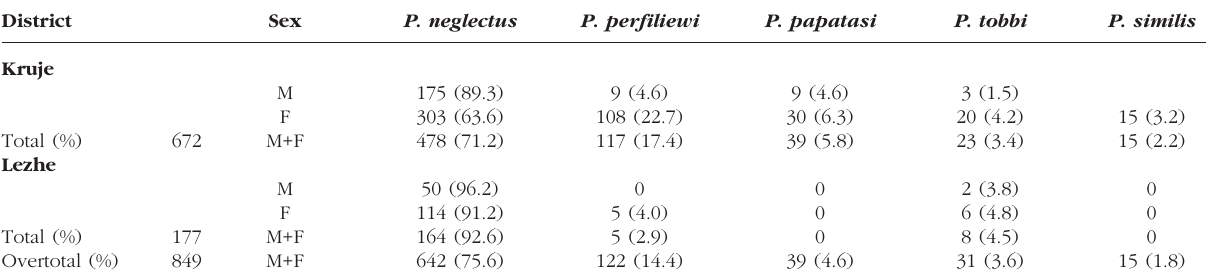
Table II. – Prevalence of the sandfly species identified in each district. M, male; F, female.